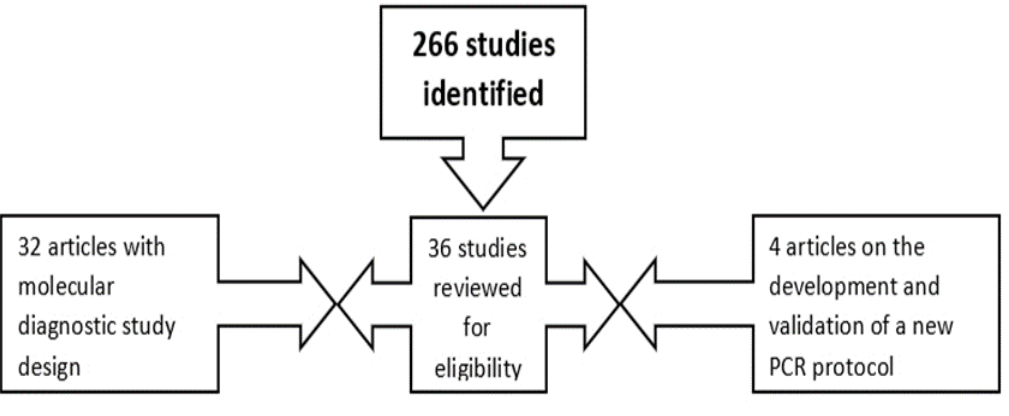
Figure 1. Selection process of studies using molecular diagnostic methods